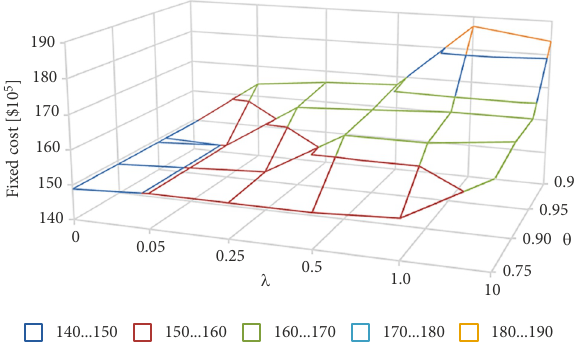
Figure 7. The optimal fixed cost under different confidence levels for case 10–1